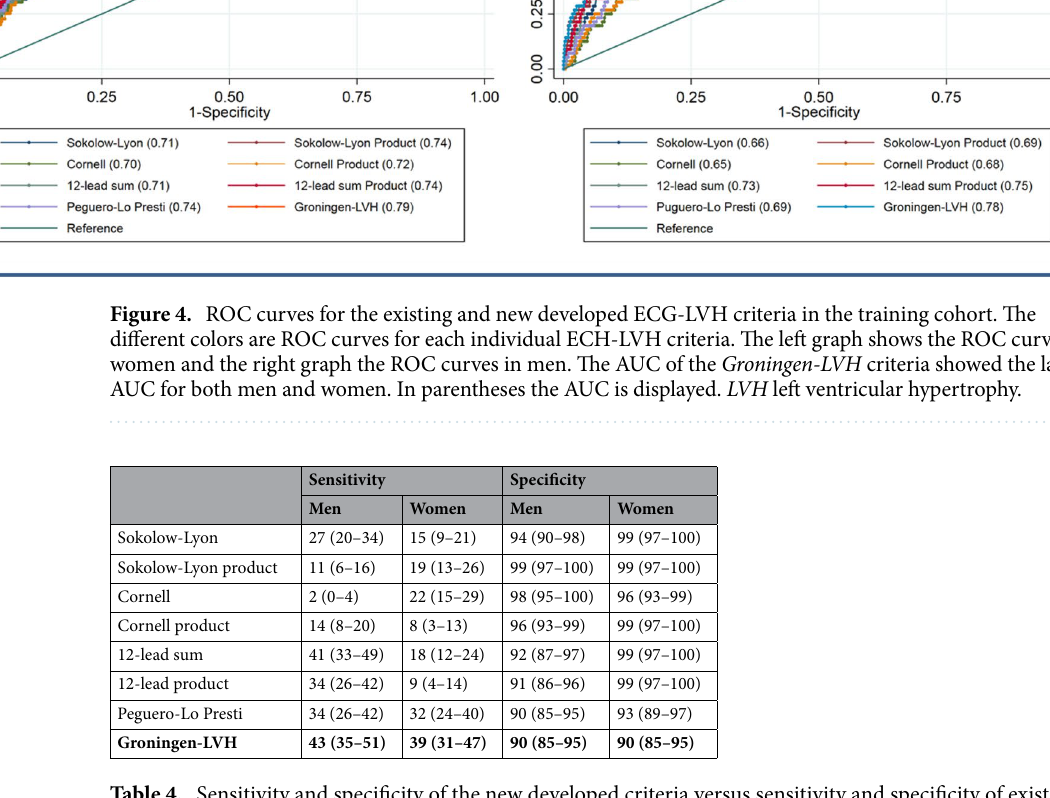
Table 4. Sensitivity and specificity of the new developed criteria versus sensitivity and specificity of existing criteria in the training cohort. LVH left ventricular hypertrophy.